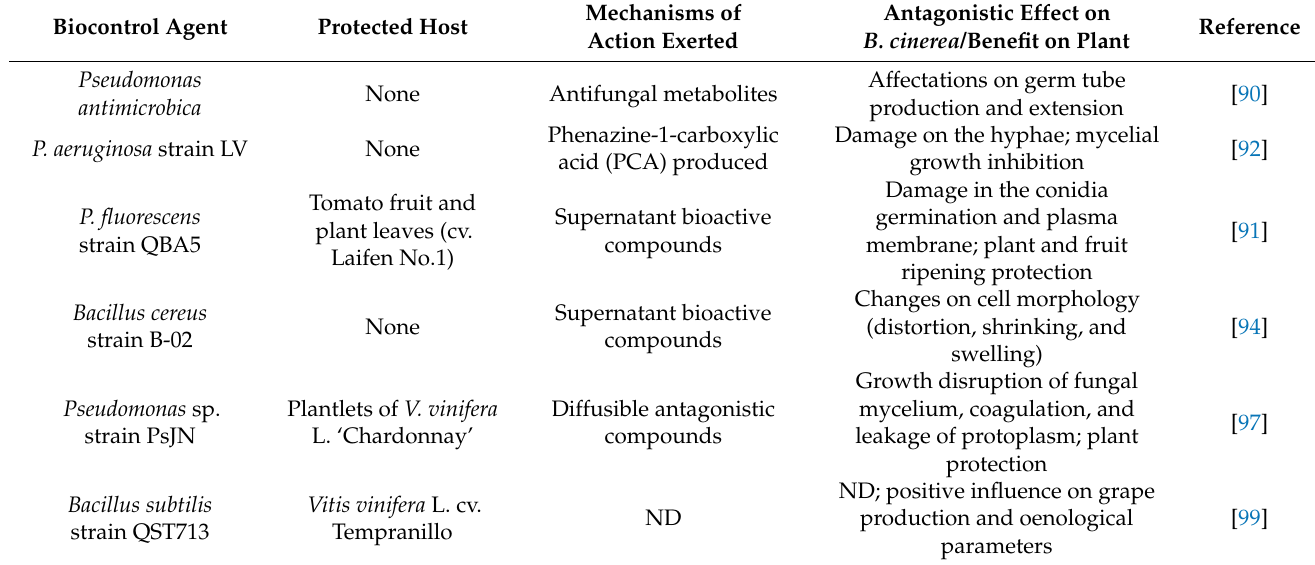
Table 1. Examples of works reviewed highlighting the action mechanisms and antagonistic effects exerted against the grey mould phytopathogen B. cinerea . Some works also show the dual activity of plant protection and stimulation of plant growth by plant growth-promoting bacteria. ND means not